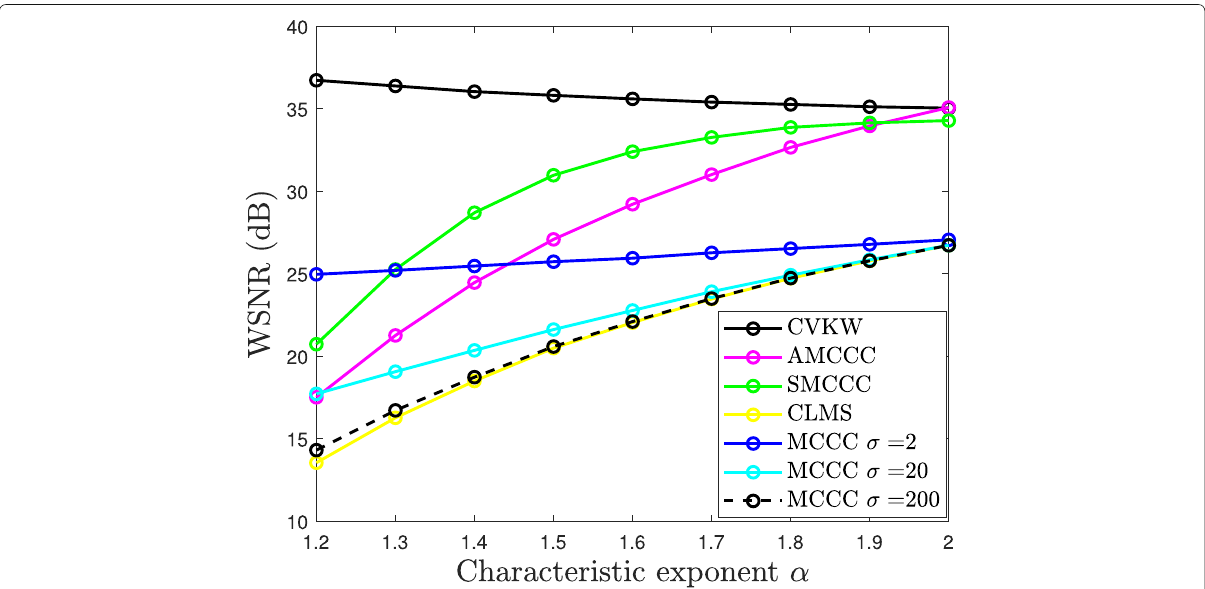
Fig. 4 Performance comparison among several methods in terms of WSNR as a function of the characteristic exponent and GSNR = 20